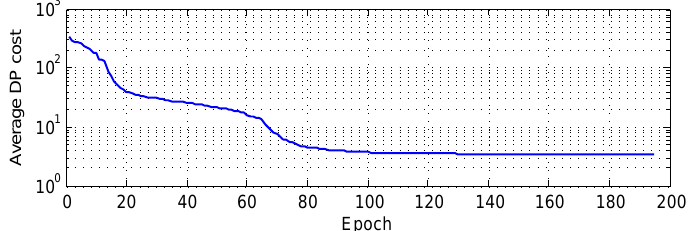
Figure 7. Average dynamic programming (DP) cost per trajectory for training the neural